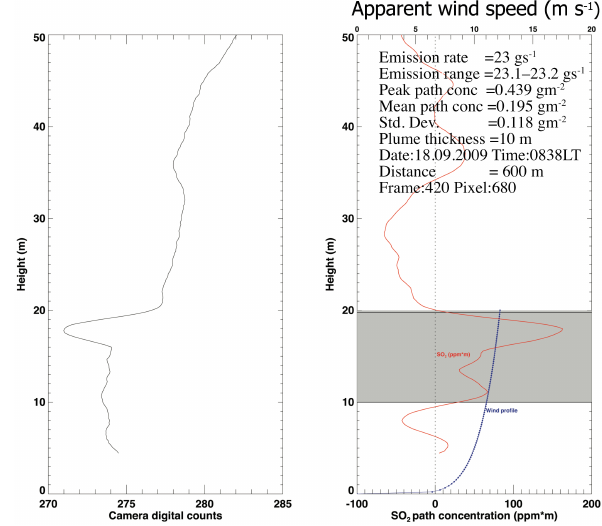
Fig. 13. SO 2 path concentration ( u , in ppmm) for the NS Concept .